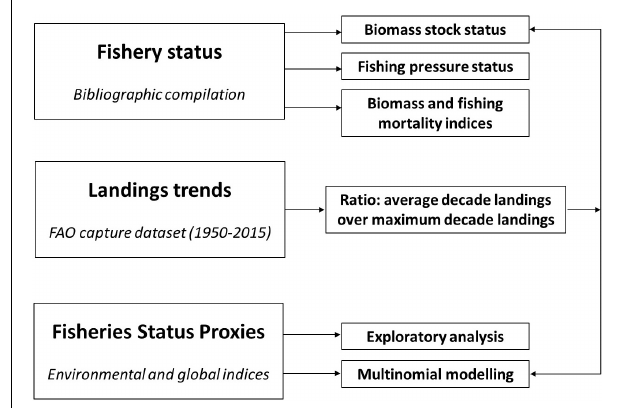
FIGURE 1 | Schematic representation of the methods applied in this study to investigate the sustainability status of snapper and grouper fisheries worldwide.